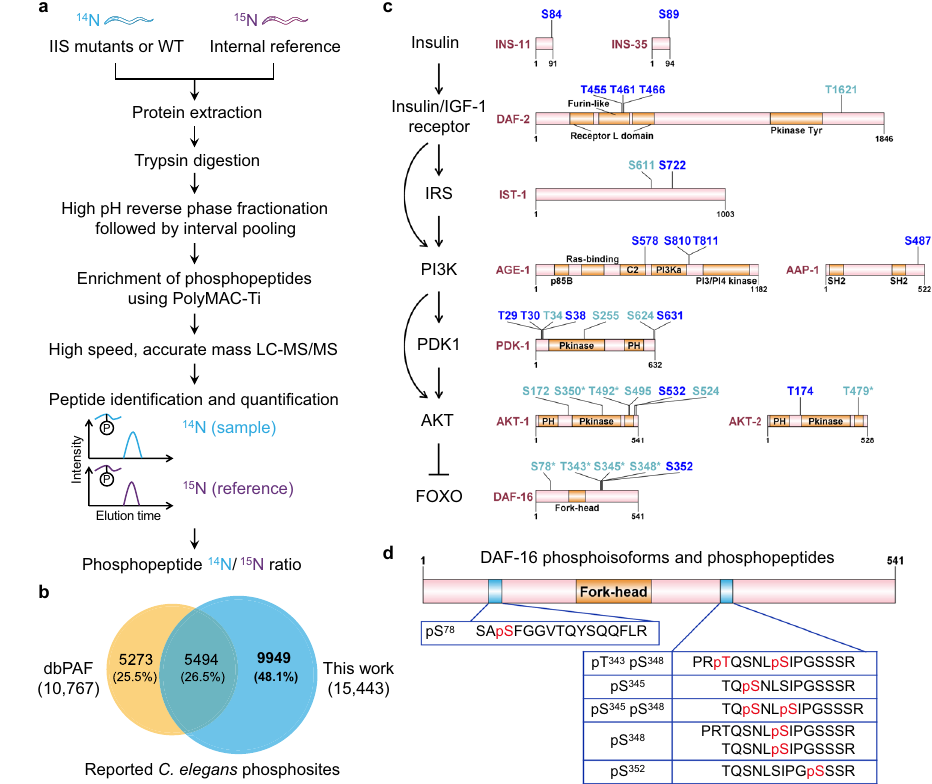
Fig. 1 Characterization of the C. elegans phosphoproteome. a Phosphoproteomics pro fi ling of WT and IIS mutants by advanced techniques, including extensive high-pH reverse phase fractionation followed by interval pooling, polyMAC-Ti enrichment of phosphopeptides, as well as high-speed,